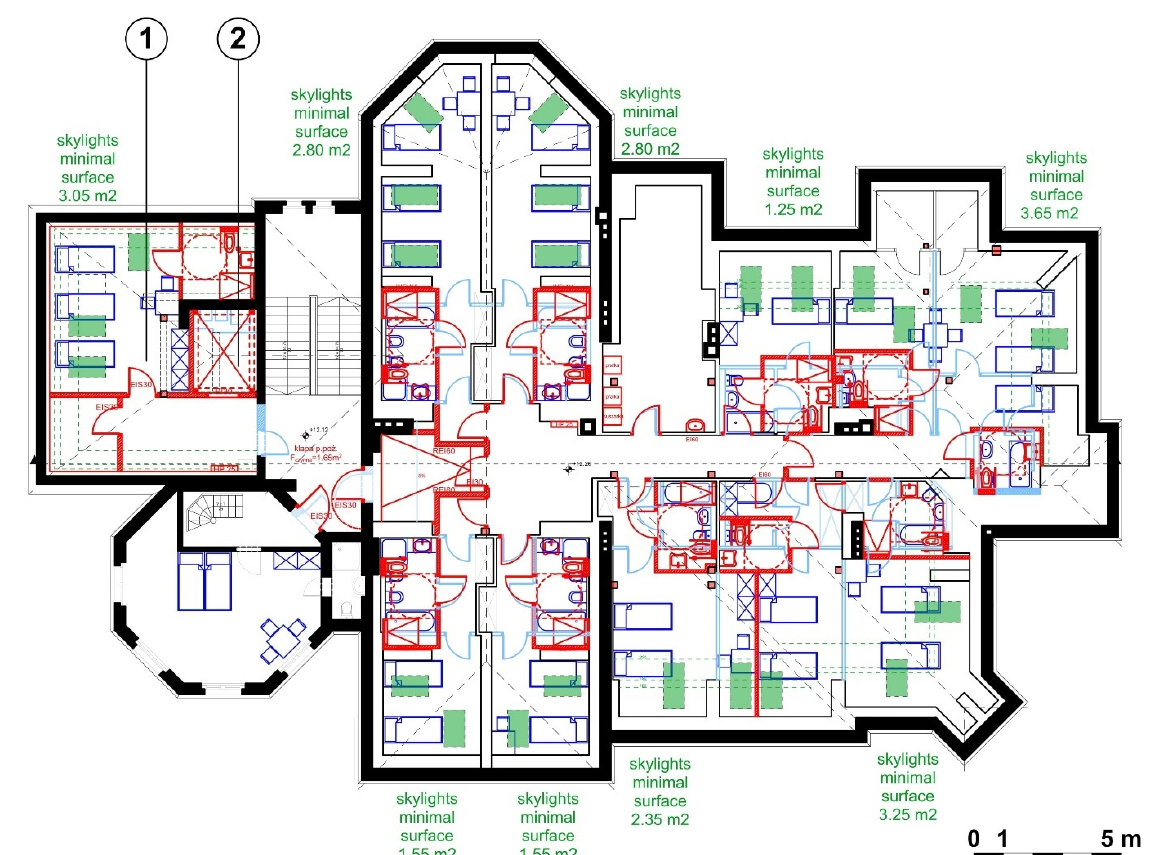
Figure 11. The adaptive re-use of the interiors of the Palace in Maciejewo for a nursing home function. Projection of the attic floor arrangement with introduced essential changes: 1—new arrangement of rooms with individual bathrooms and new roof skylights; 2—the new passenger-goods lift with rescue function. Project developed by: Urbicon Sp ó łka z o.o. Szczecin;